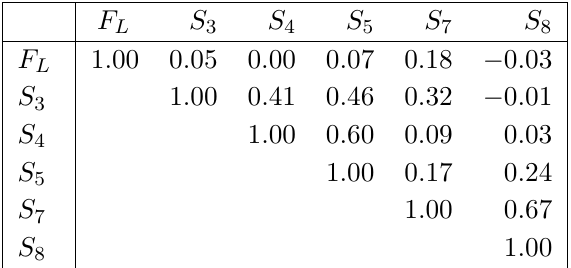
and S parameters obtained for q 2 2 L